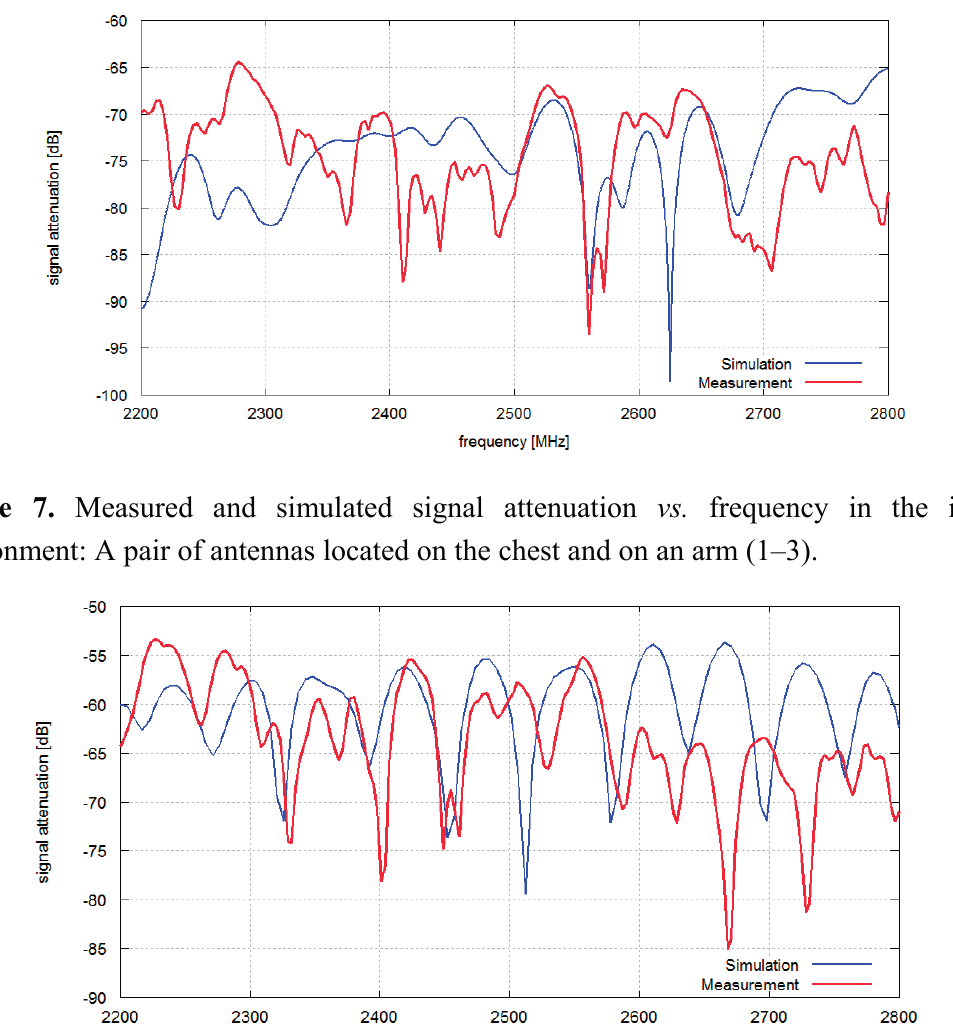
Figure 6. Measured and simulated signal attenuation vs. frequency in the indoor environment: A pair of antennas located on the chest and on the back (1–2).